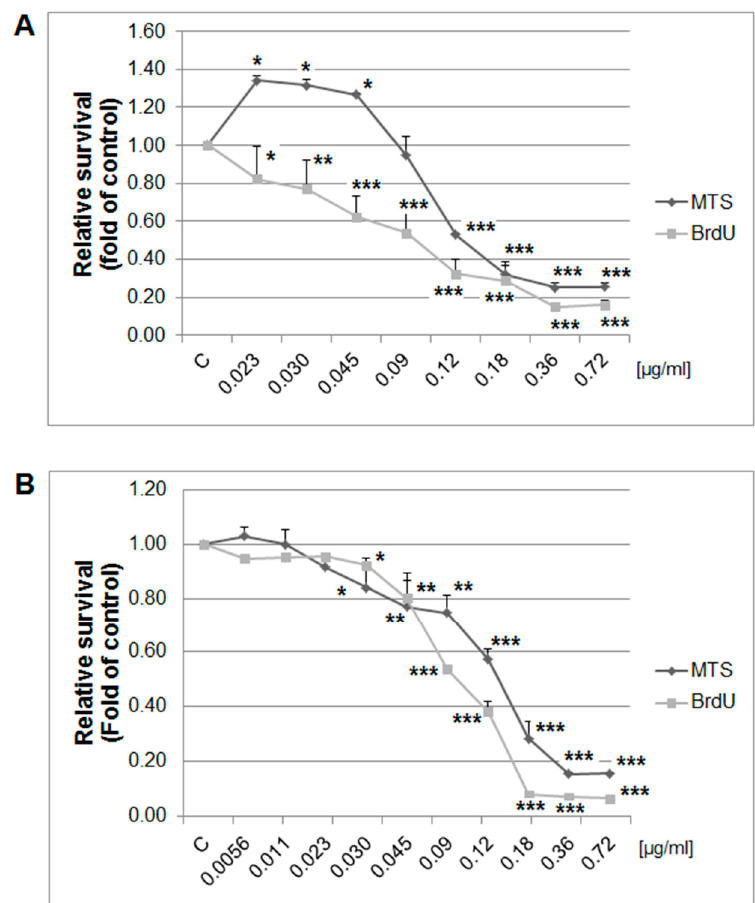
Figure 8. Relative survival of MCF-7 ( A ) and MDA-MB-231 ( B ) cells treated with EOT (0.72–0.023/0.0056 µg/mL) and analyzed by MTS and 5-bromo-20-deoxyuridine (BrdU) incorporation assays. Data were obtained from three independent experiments and significant differences were marked as * p < 0.05, ** p < 0.01, and *** p < 0.001 versus control cells (untreated).